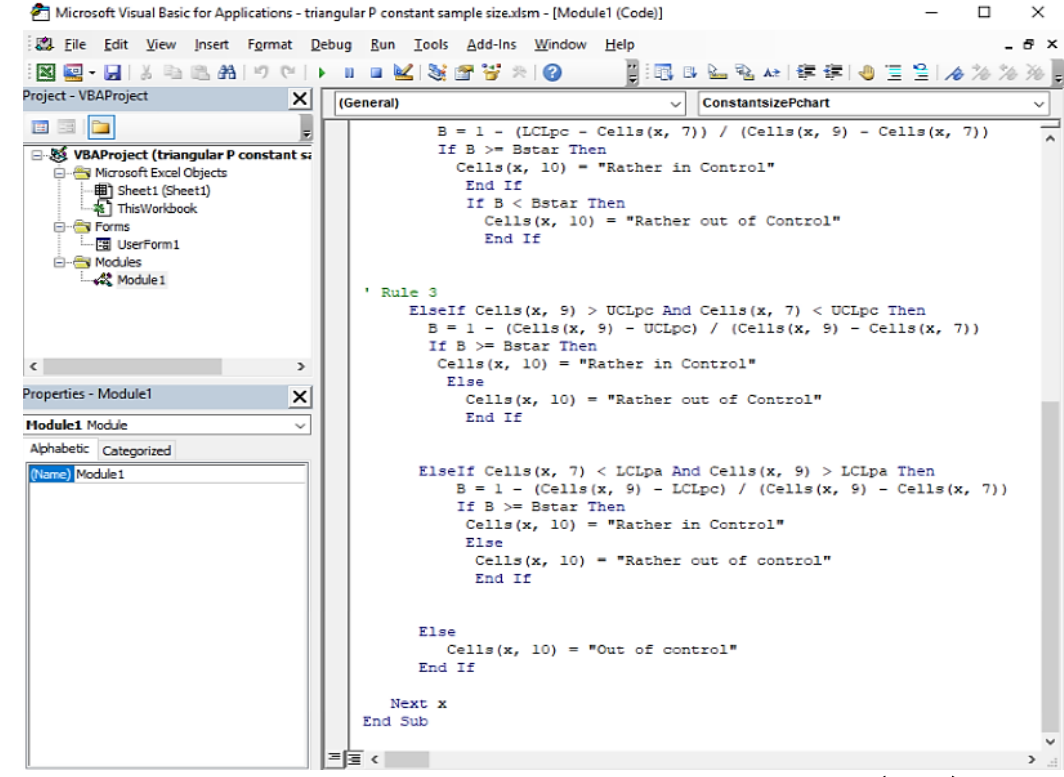
Figure 6. Visual Basic Coding for the Process Condition Algorithms (part 2).